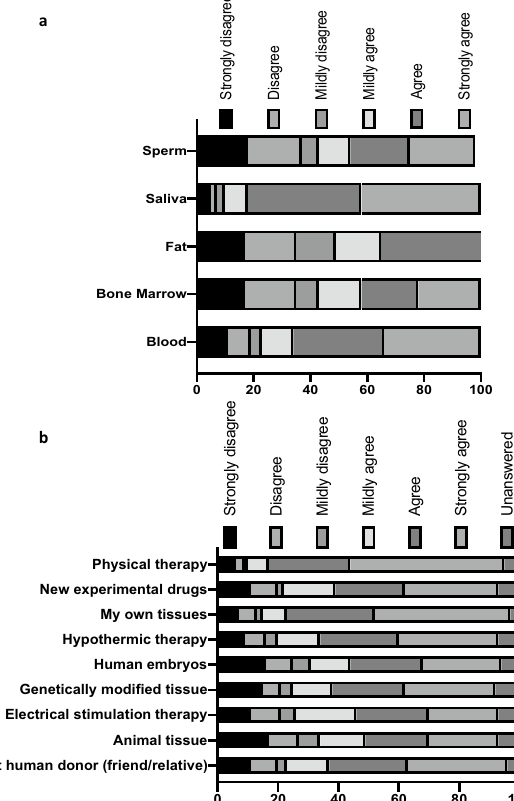
Figure 1. ( a ) Bar graph displaying participant responses to the statement: “I would like to be more involved in scientific research, including donating the following for research purposes:” ( b ) Bar graph displaying participant responses to the statement: “I would consider taking part in an experimental treatment or clinical trial that involved the use